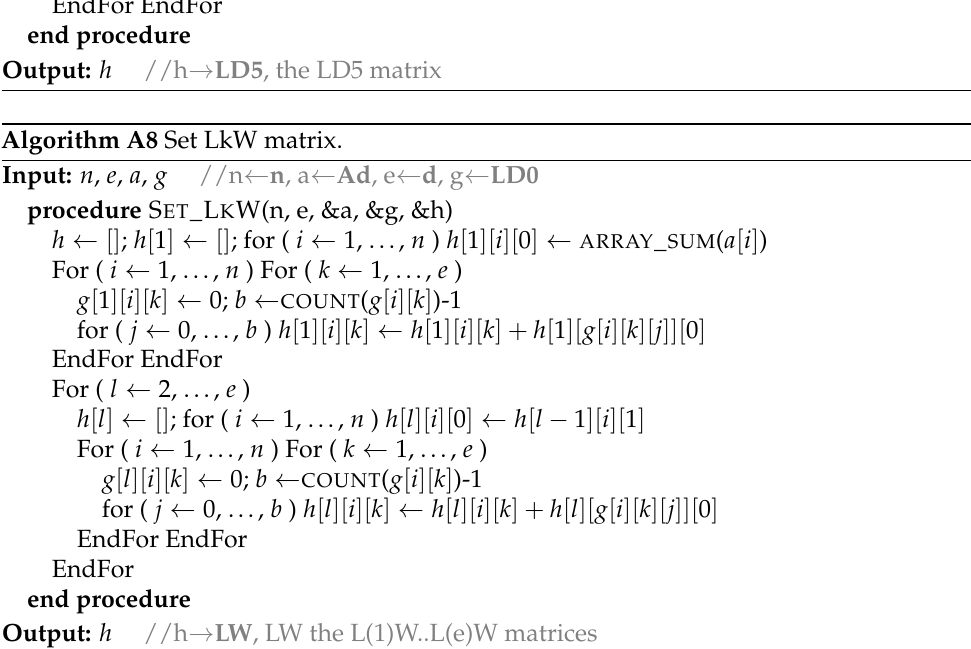
Algorithm A7 Set LD5 matrix.